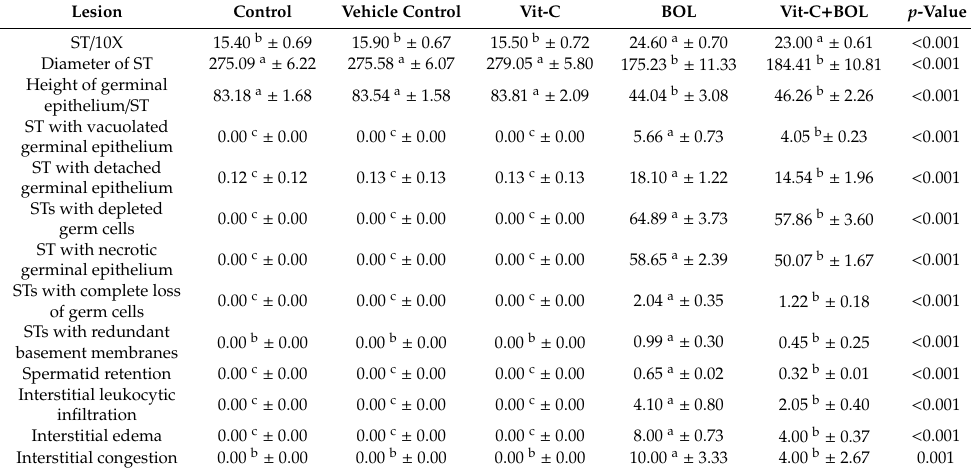
BOL: boldenone and Vit-C: vitamin C.Values are mean ± SE for n = 5 samples / group. Means within the same row (in each parameter) carrying di ff erent superscripts (a, b, and c) are significantly di ff erent at p < 0.05 groups. Data are expressed as the mean ± SE ( n = 8 replicates). Columns carrying di ff erent superscripts ( a–c ) are significantly di ff erent (one-way ANOVA).